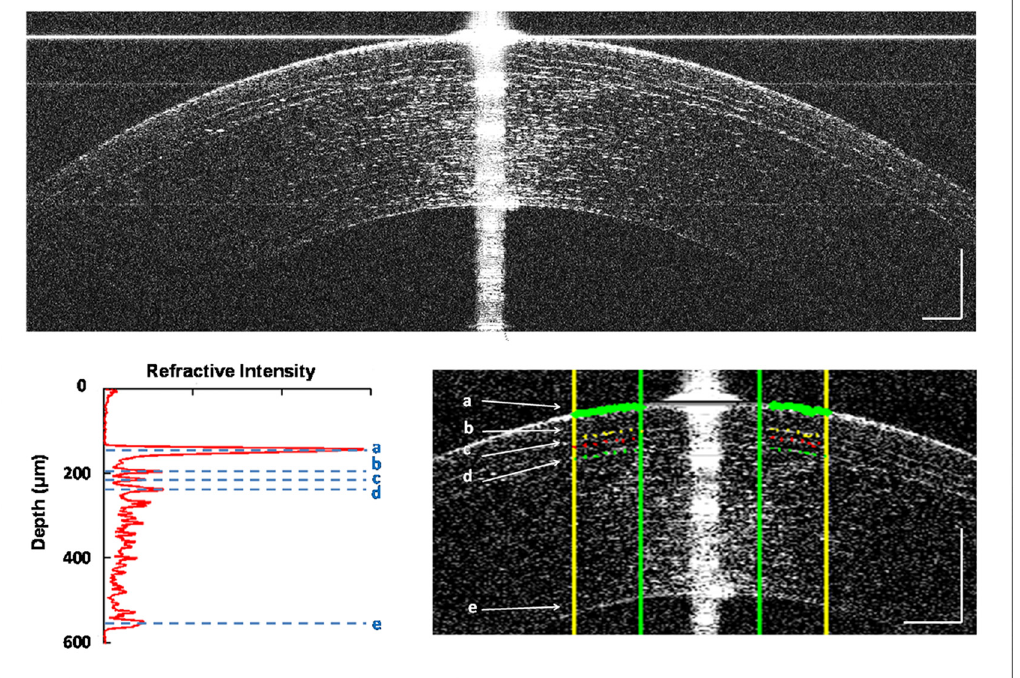
Fig 2. UHR-OCT image illustration of the image processing procedure. (A) Original UHR-OCT image taken 1 day after SBK for which the flap was made with the One-Use Plus SBK Moria microkeratome. Similar images were obtained after SBK in which the flap was made by FEMTO laser. (B) Longitudinal reflective profile of the detected central cornea sublayers. (C) Automated segmentation of central corneal region virtually eliminated the vertical specular reflex and horizontal artifacts. The distances between (a) and (b), (b) and (c), (a) and (d), (a) and (e) represent the thickness of the epithelium, Bowman 0 s layer, corneal flap, and total cornea thickness respectively. Bars = 250 μ